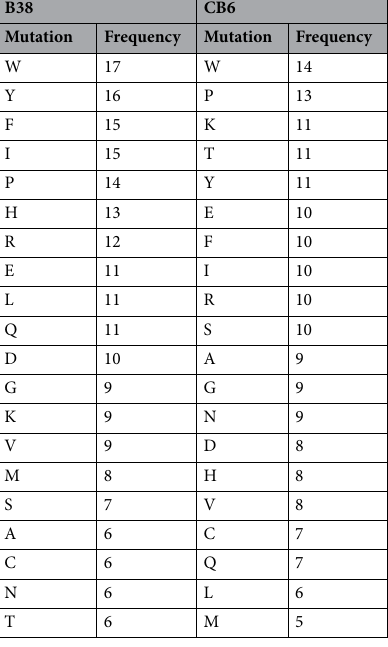
Table 2. Residue type frequencies for predicted escape mutations B38 and CB6 are shown left and right respectively. The mutated residue is indicated in the left subcolumn for each and the frequency it occurs in our escape dataset is shown on the